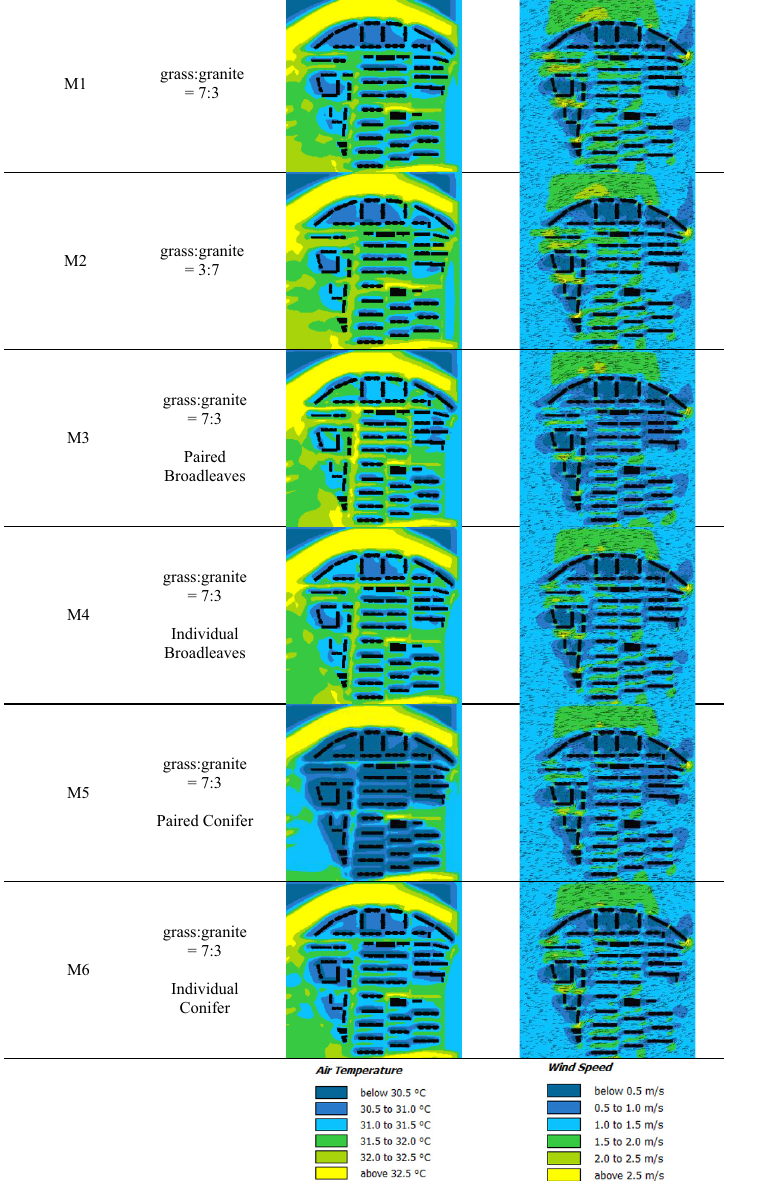
Figure 4. Simulation results